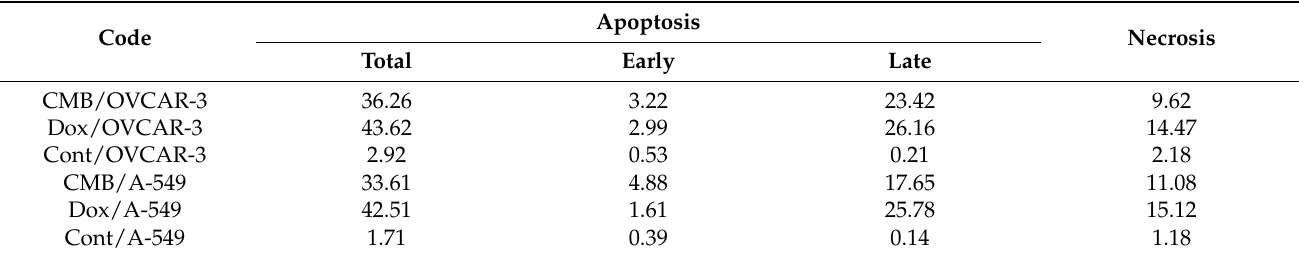
Table 1. Distribution of apoptotic cells in the OVCAR − 3 and A − 549 cell lines following CMB and Doxorubicin treatment, as assessed by the Annexin V-FITC assay.